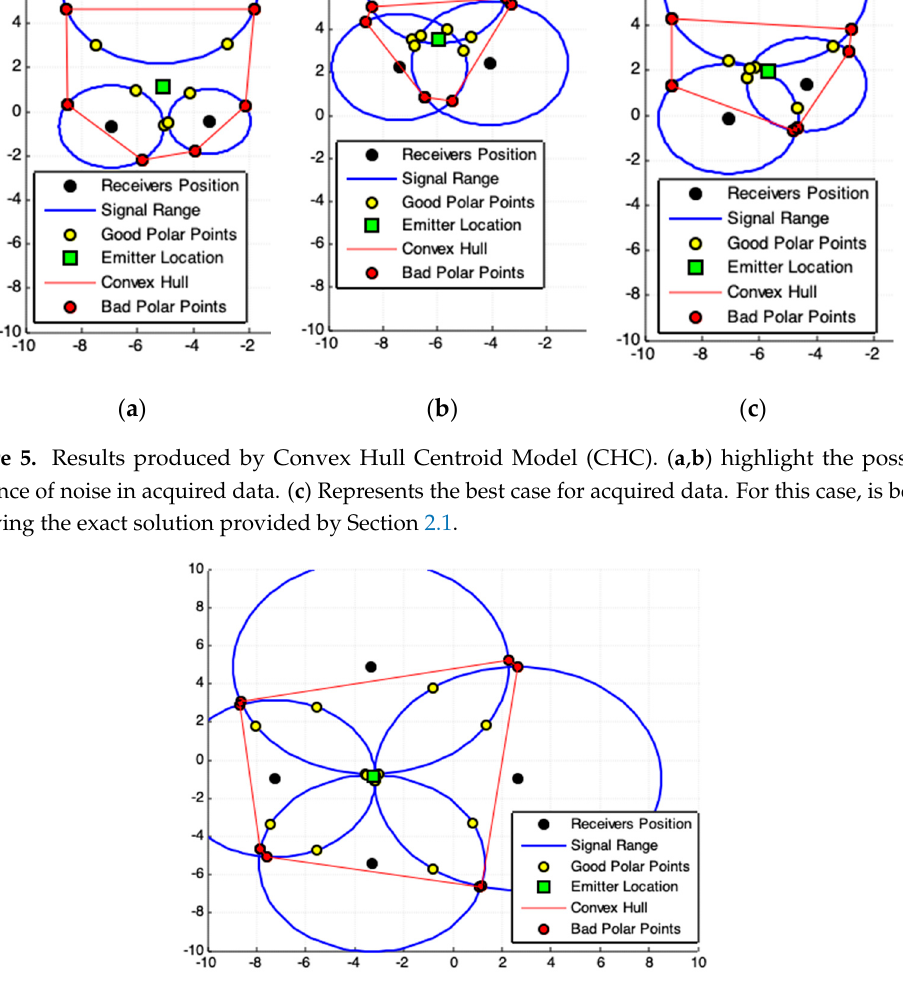
Figure 6. Results produced by CHC using satisfactory redundant data (four receivers). For this case, is better applying the exact solution provided by Section 2.1.